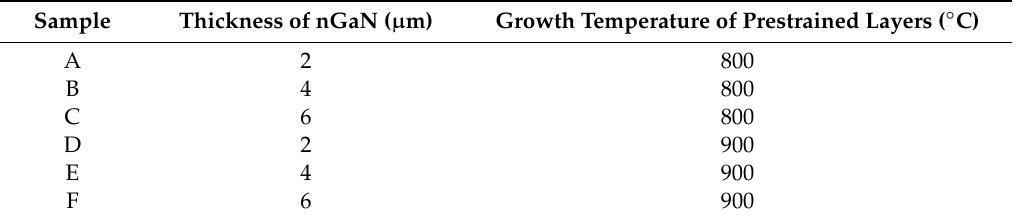
Table 1. Samples A–F with their thickness of nGaN and growth temperature of prestrained layers. Sample Thickness of nGaN ( µ